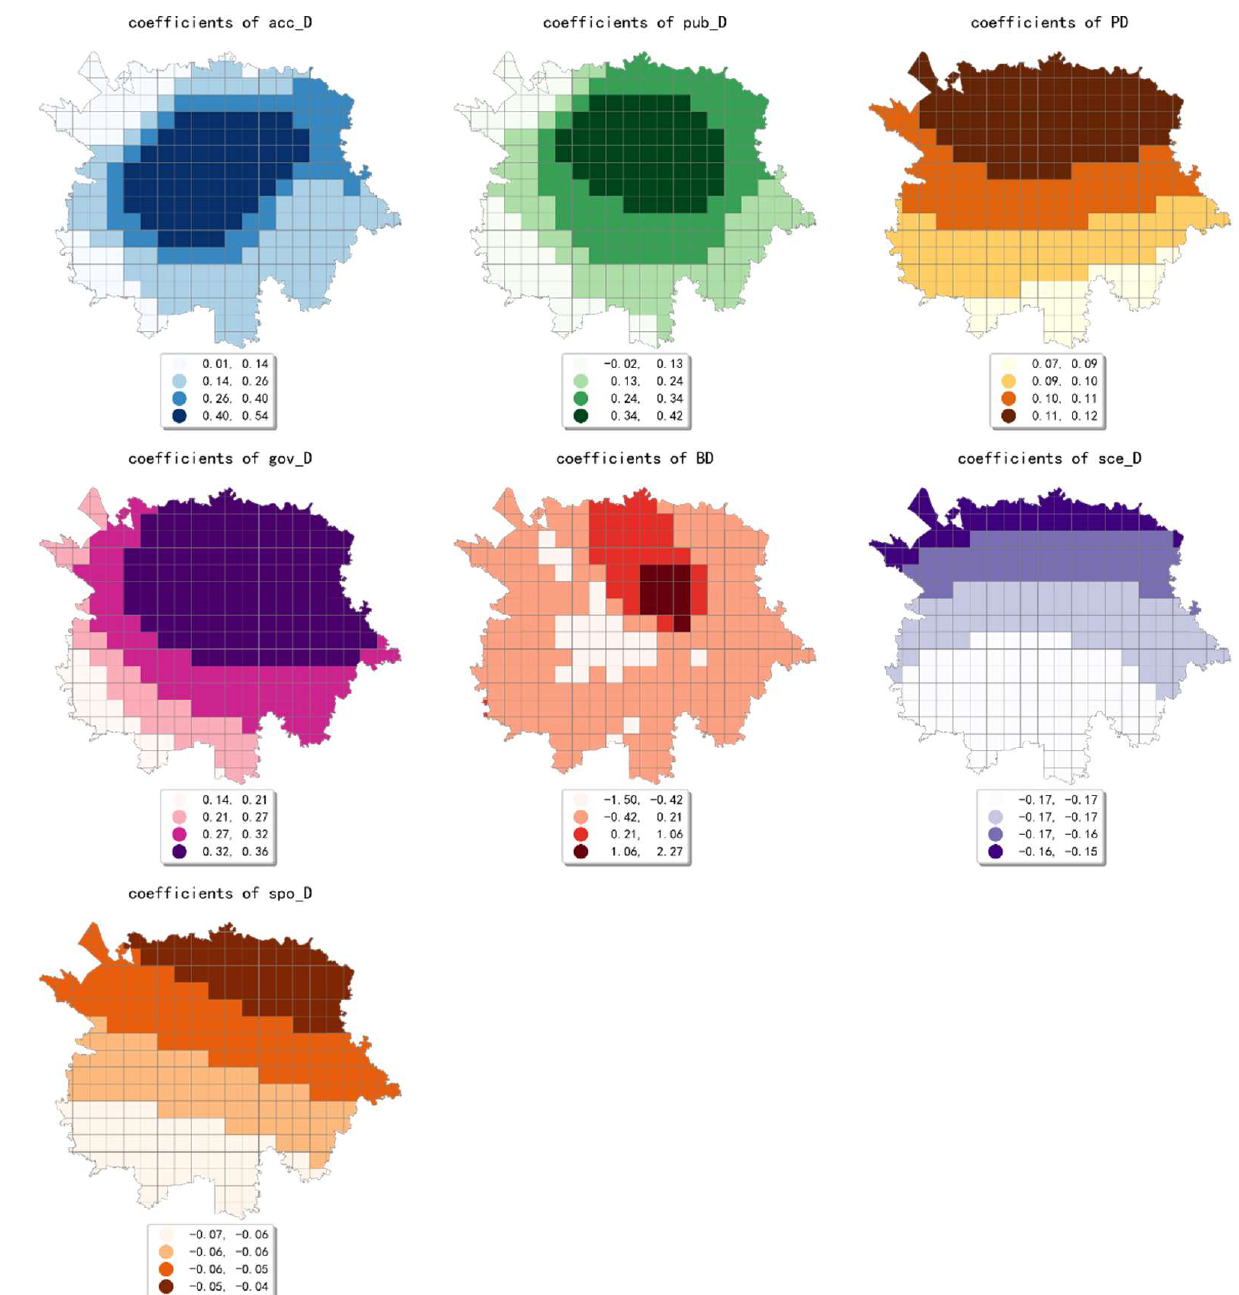
Figure 5. The estimated coefficient maps in the grid with 2000 m.